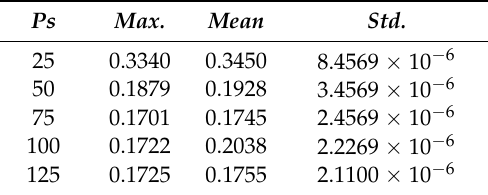
Table 5. Estimation error versus number of particles ps